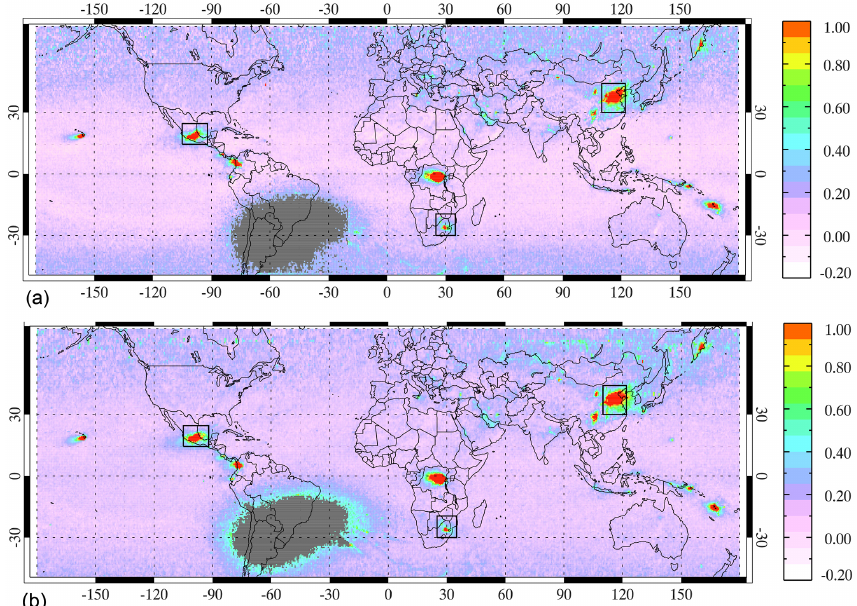
Figure 1. Annual SO 2 loading (unit: DU) in 2012 for OMI (a) and OMPS (b) . Both OMI and OMPS SO 2 maps are gridded to 0.5 ◦ × 0.5 ◦ grid cells. The three black boxes are regions for eastern China, Mexico, and South Africa, respectively, that will be examined in more detail below. The grey shaded area shows the area affected by the South Atlantic Anomaly.